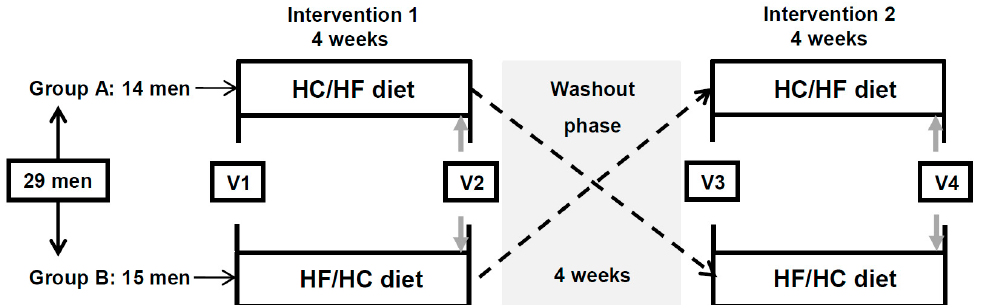
Figure 1. Study design. 29 non-obese men participated in this cross-over trial and were randomized to two 4-week isocaloric dietary interventions, which were separated by a 4-week washout phase. Before (V1 and V3) and after (V2 and V4) each dietary intervention, participants were clinically examined. Prior to V2 and V4 (i.e., last day of the intervention, indicated by grey arrows), saliva samples were collected every 4 hours over 24 hours. HC / HF diet, isocaloric high-carb meals until 13:30 and isocaloric high-fat meals between 16:30 and 22:00; HF / HC diet, reversed order of meal sequence; V, visit.